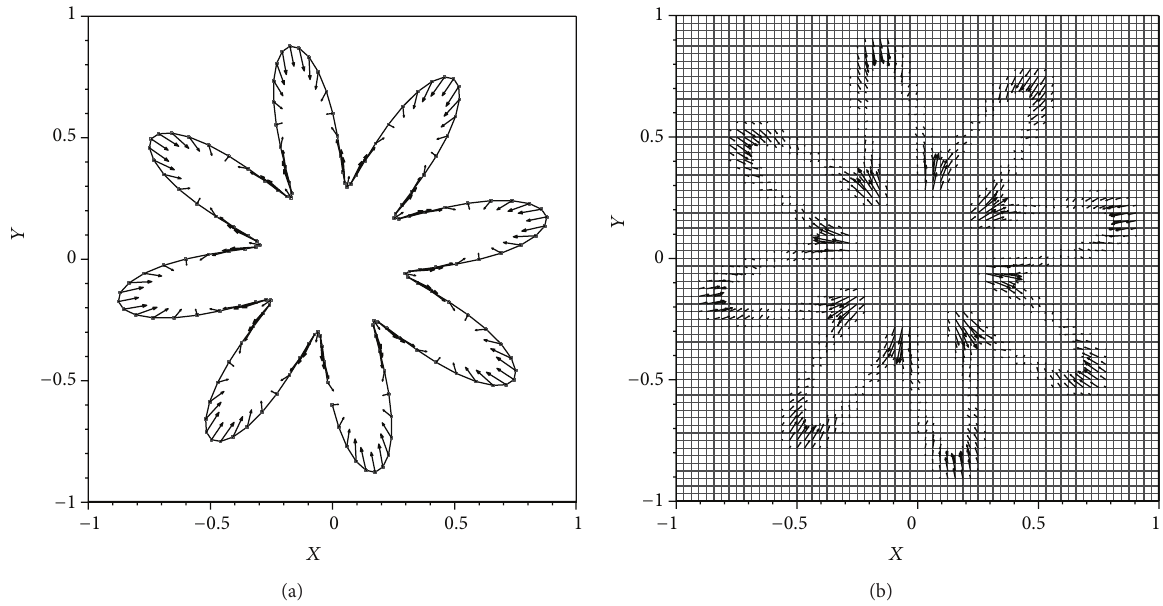
Figure 2: (a) Lagrangian forces associated with the elastic boundary at 𝑡 = 0 ; (b) Eulerian force associated with the fluid domain at 𝑡 = 0 .